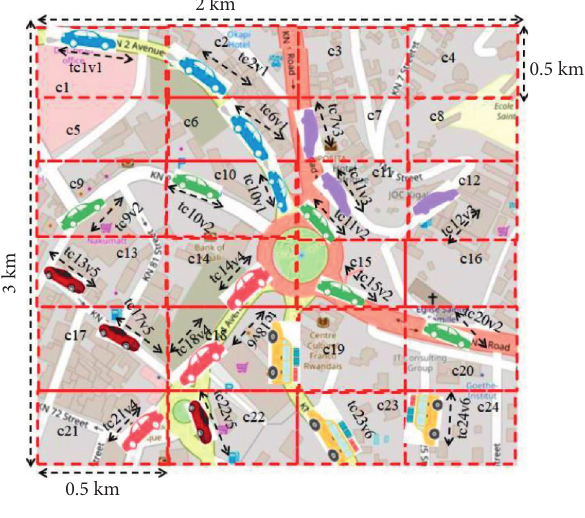
Figure 14: Vehicle paths.